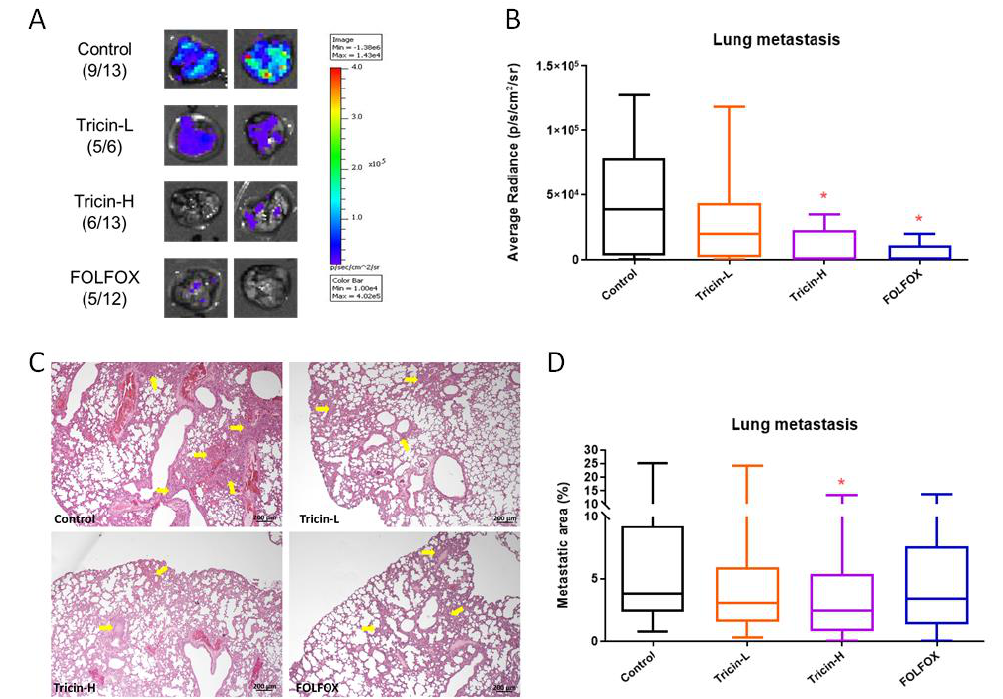
Figure 4. Effects of tricin and FOLFOX on lung metastasis in orthotopic colon tumor-bearing mice. ( A ) Representative images of lungs obtained from different groups at end point of IVIS scan, and the fractional number revealed the frequency of metastasis detected in mice of each group. ( B ) Graph showed the bioluminescence measurements (expressed as average radiance) in lungs. Lungs were also collected and embedded in paraffin. Sections of lungs were stained with H & E and photographed. ( C ) Representative photos showed tumor nodules (yellow arrows) in lung sections. ( D ) Tumor burden were presented as the mean percentage of metastatic area. Mean + S.E.M., n = 7–13 in each group. Differences among treatment groups were determined by one-way ANOVA followed by Tukey’s multiple comparisons test, * p < 0.05 as compared with control group.